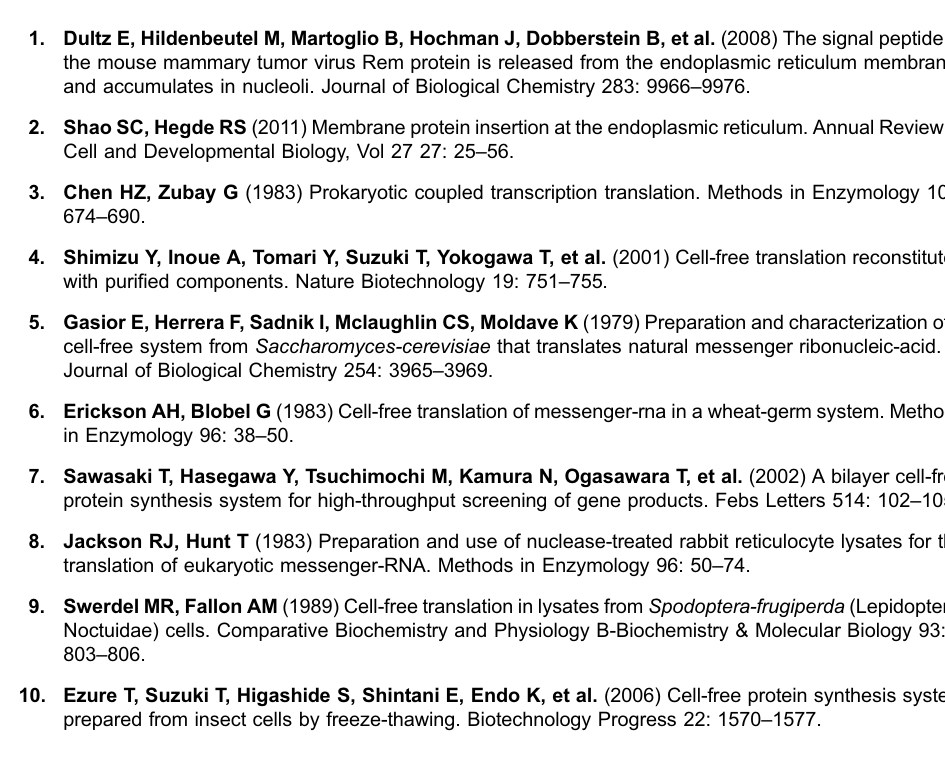
S1 Figure. SDS-polyacrylamide gel electrophoresis (12.5%) of 2 m l of the insect cell extract used for cell-free translation (lysate) and 0.4 m l of the microsomes (Sf21mm). The insect cell extract was prepared as described previously